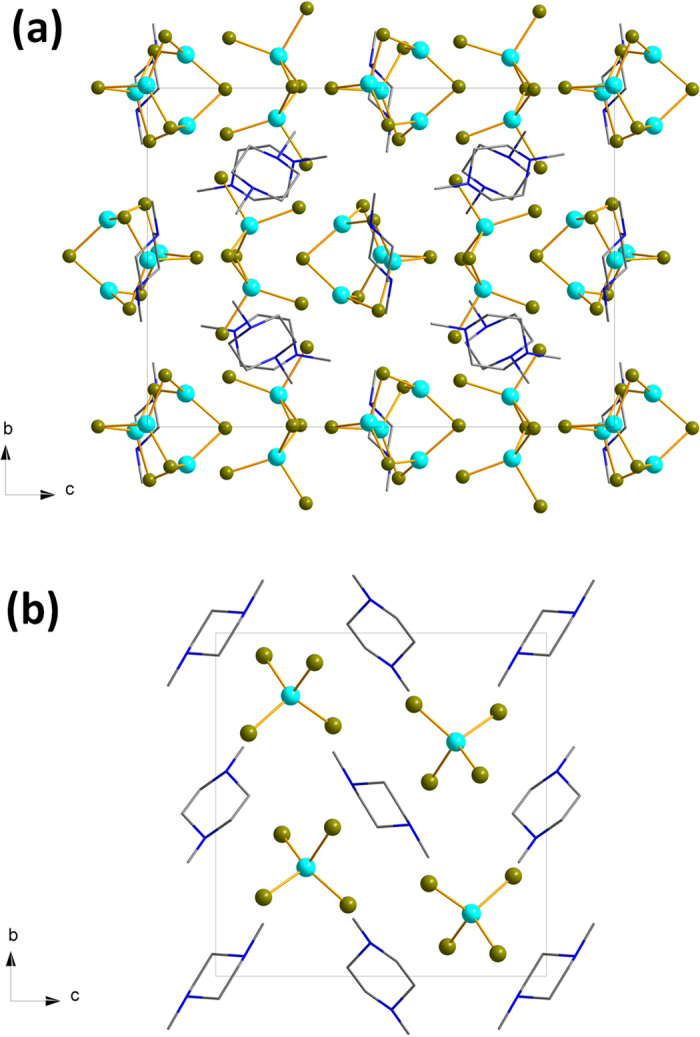
Representation of the two d10 metal halides (a) [C6H16N2]3[Cu4Br6][Cu2Br6] (1) and (b) [C6H16N2]ZnBr4 (2)).